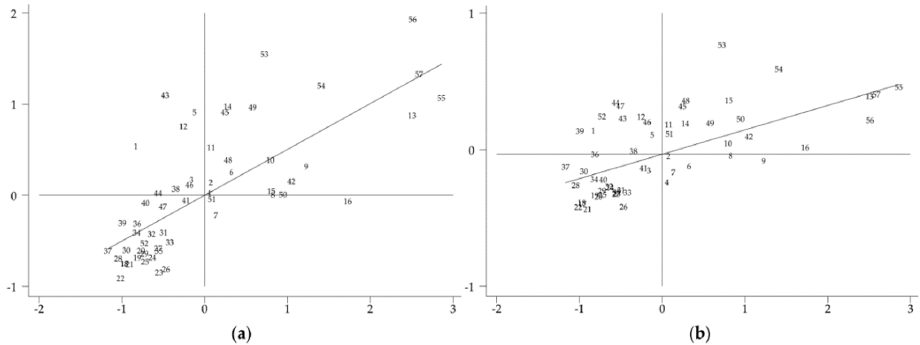
Figure 3. Moran scatter plots of carbon emission intensity in the YRB in 2017. ( a ) Based on the adja ‐ cency weight matrix; ( b ) Based on spatial geographic weight matrix. adjacency weight matrix; ( b ) Based on spatial geographic weight